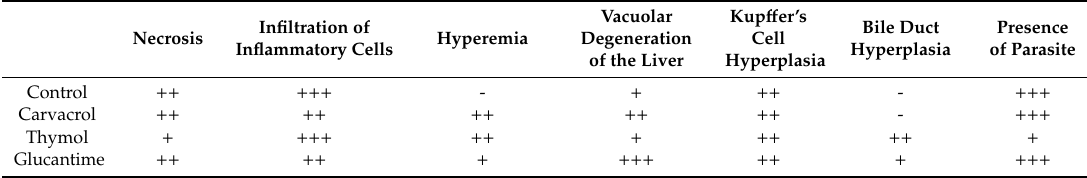
Figure 2. Liver tissue. A , B , C : control group; D , E , F : carvacrol group; G , H , I : glucantime group; J , K , L : thymol group; vacuolar degeneration (1), parasites in hepatocytes (2), inflammatory cells infiltration, hyperemia (3), bill duct hyperplasia (4); H&E staining, 40 × , 100 × magnification. Table 2. Histological alteration of hamster livers in the groups treated with carvacrol, thymol and glucantime in comparison with the control